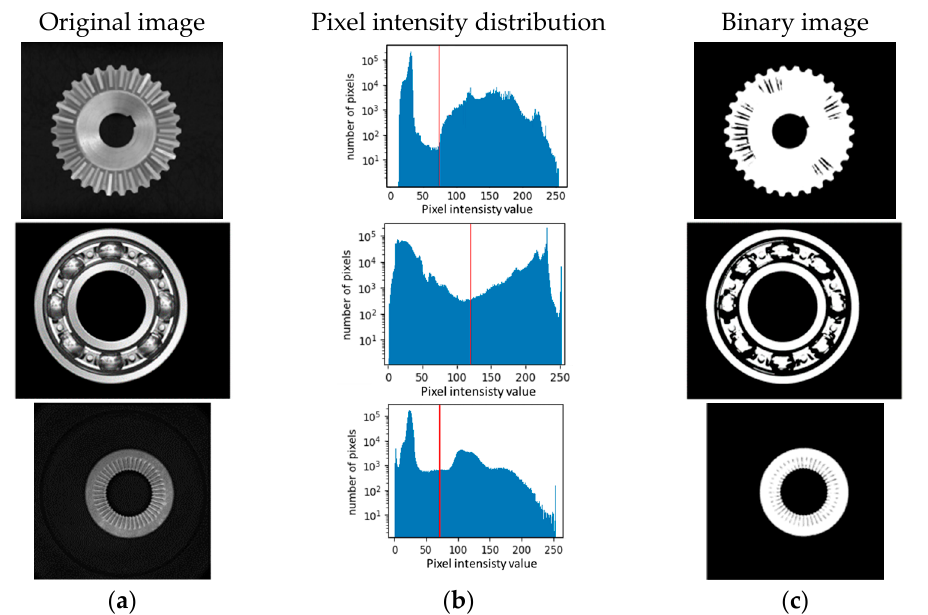
Figure 1. Automatic thresholding of a conic gear wheel (first row) and of a ball bearing (second row) and a washer (third row). Column ( a ) shows the original images; column ( b ) shows the histograms of pixel intensity distribution (the red lines are the thresholds computed with the Otsu method). Column ( c ) shows the binary images.